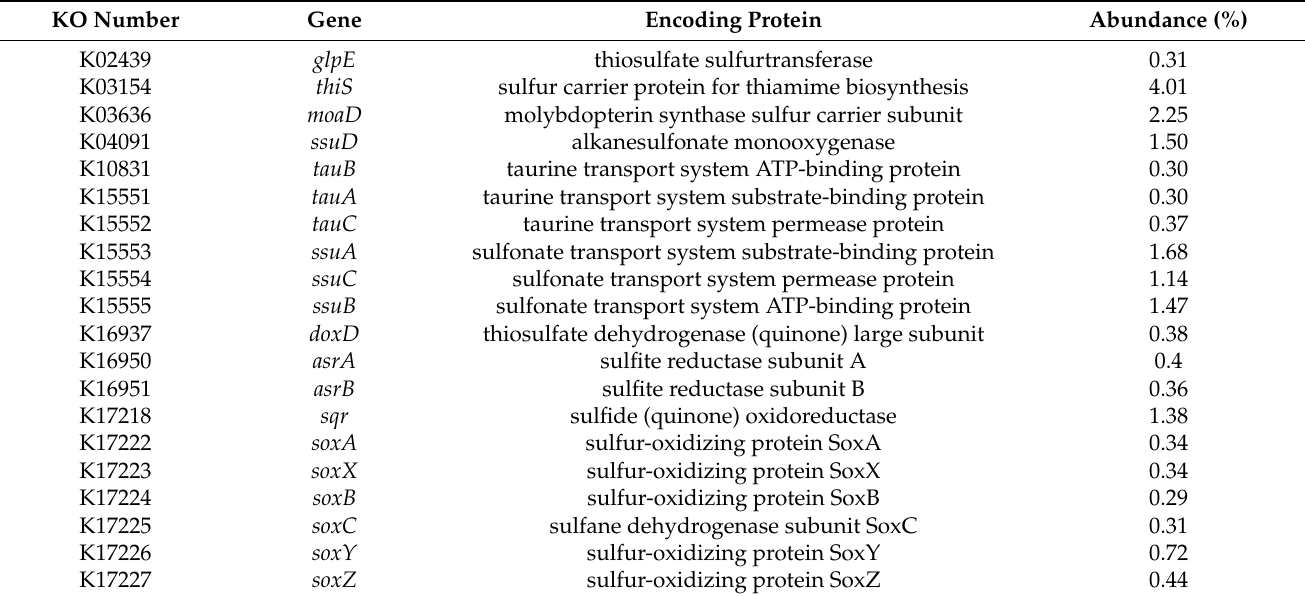
Table 1. The abundance of genes in sulfur related pathways predicted by PIRCUST software based on 16S rRNA abundance. The metabolic pathways were predicted using KEGG Orthology